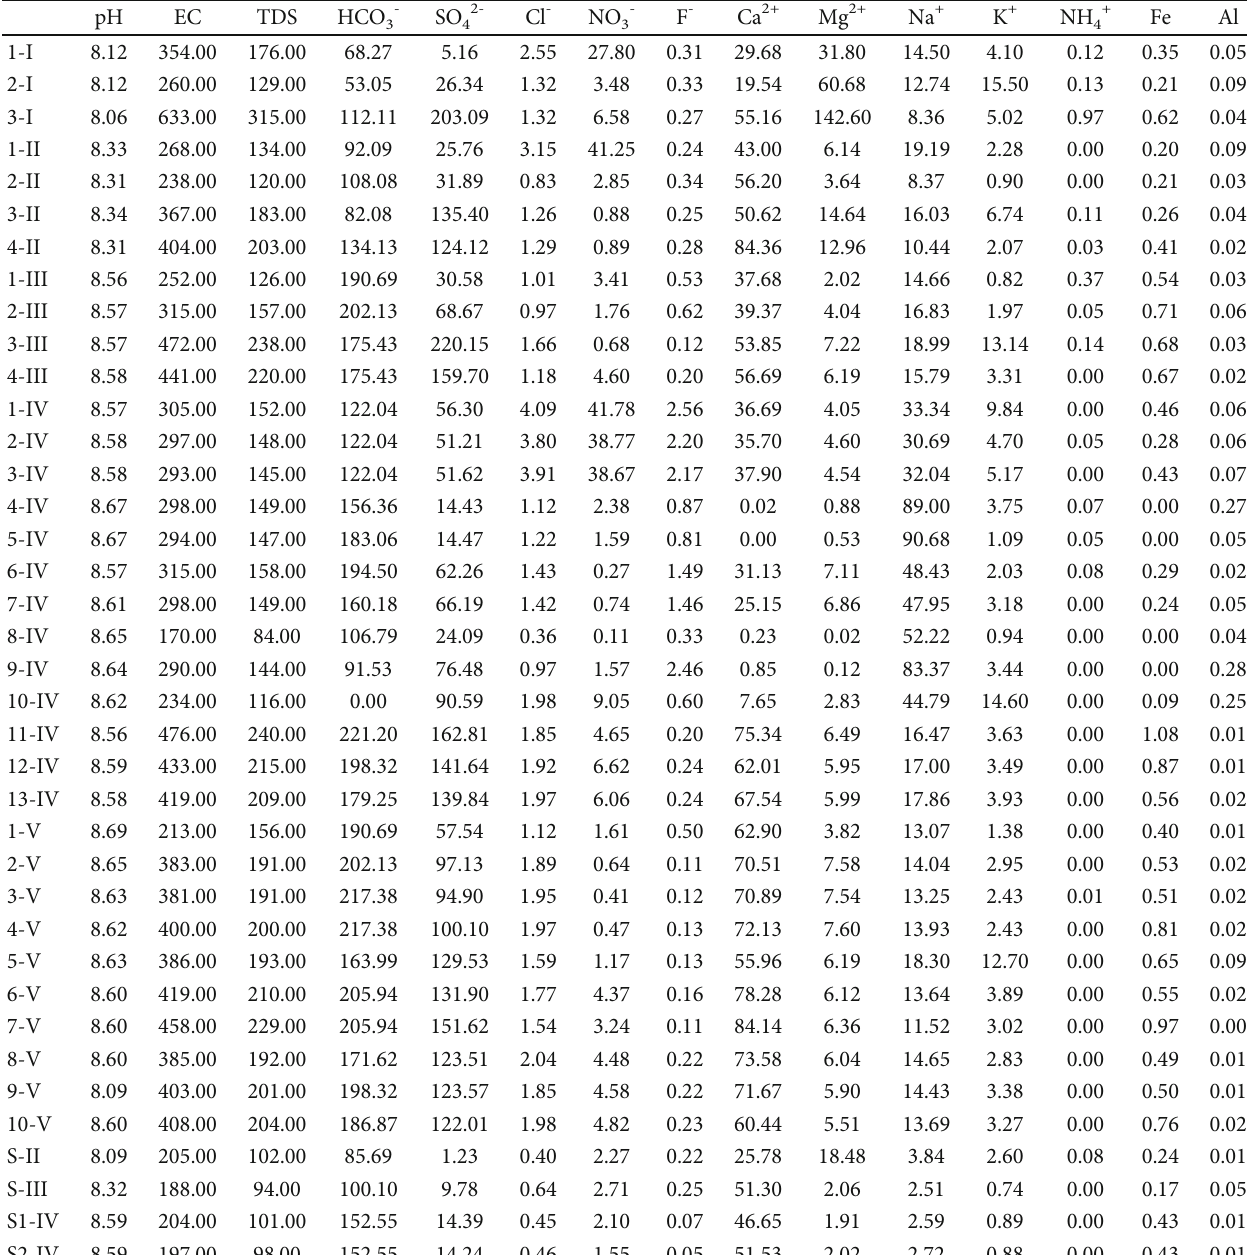
Table 3: Statistics of hydrochemical parameters (mg/L).